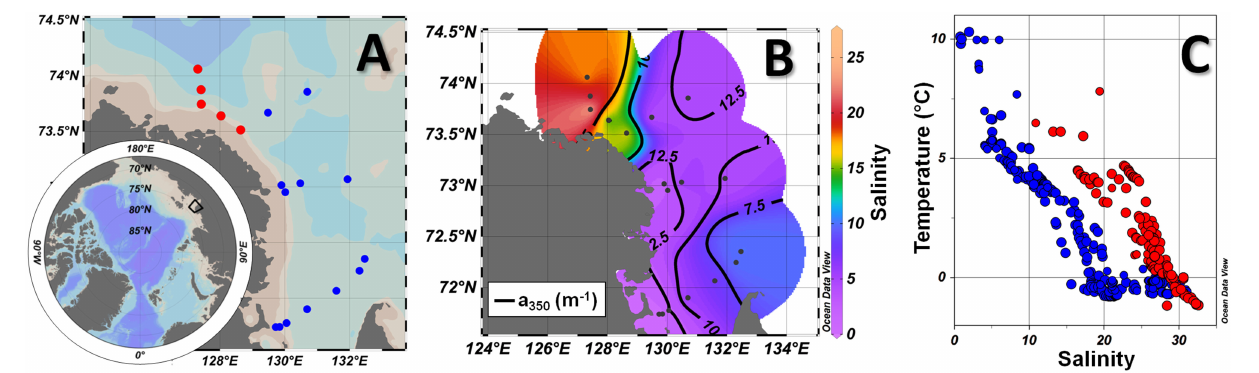
FIGURE 1 | (A) View of the Northern Hemisphere with the coverage of the sampled area in the black box, which is zoomed in highlighting the Lena delta region and southern Laptev Sea, as well as oceanographic stations and transects occupied during the Lena Expedition 2013. (B) Surface distribution of salinity (colorbar) and a 350 (m − 1 ; solid black lines). (C) T-S diagram for all the stations, with the plume-influenced and marine-influenced stations displayed in blue and red, respectively. Marine-influenced stations (surface salinity > 10) are displayed in red in (A) and in the transects. Produced with Ocean Data View (Schlitzer, 2015).